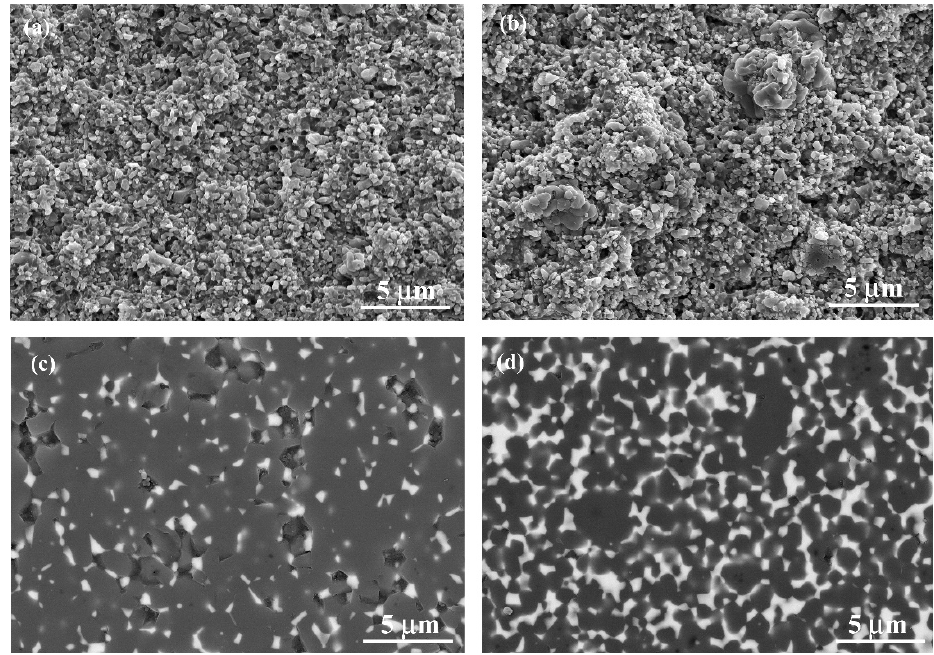
Figure 1. ( a , b ) Scanning electron microscopy (SEM) images of printed ZTA10 and ZTA30 green bodies, respectively; ( c , d ) backscattered electron images of sintered ZTA10 and ZTA30 ceramics, respectively.